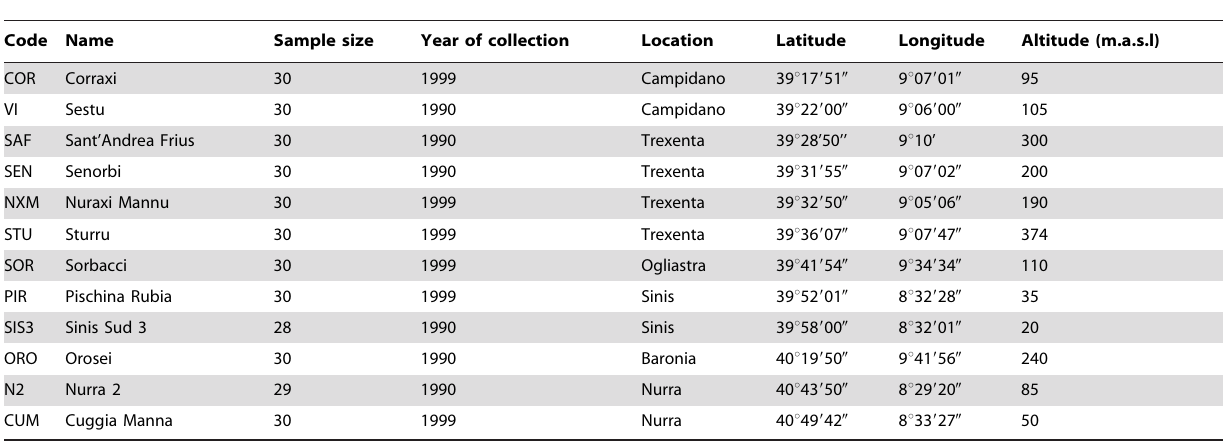
Table 1. The 12 Sardinian landrace (SL) populations used in this study (ordered by latitude).